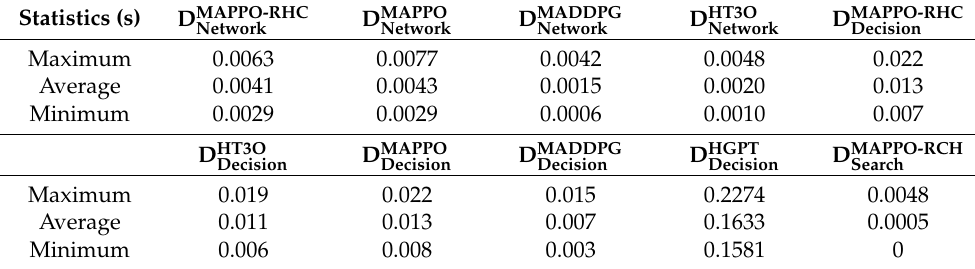
Table 3. Algorithmic calculation